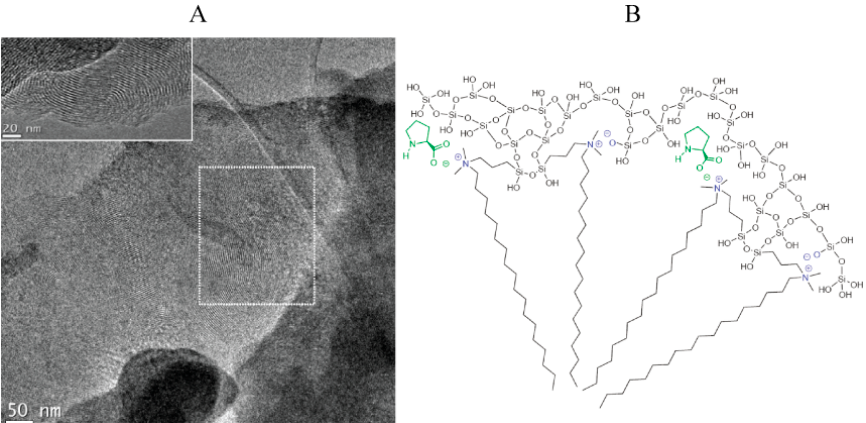
Figure 6. ( A ) TEM micrograph of the calcined material showing the different orientation of the